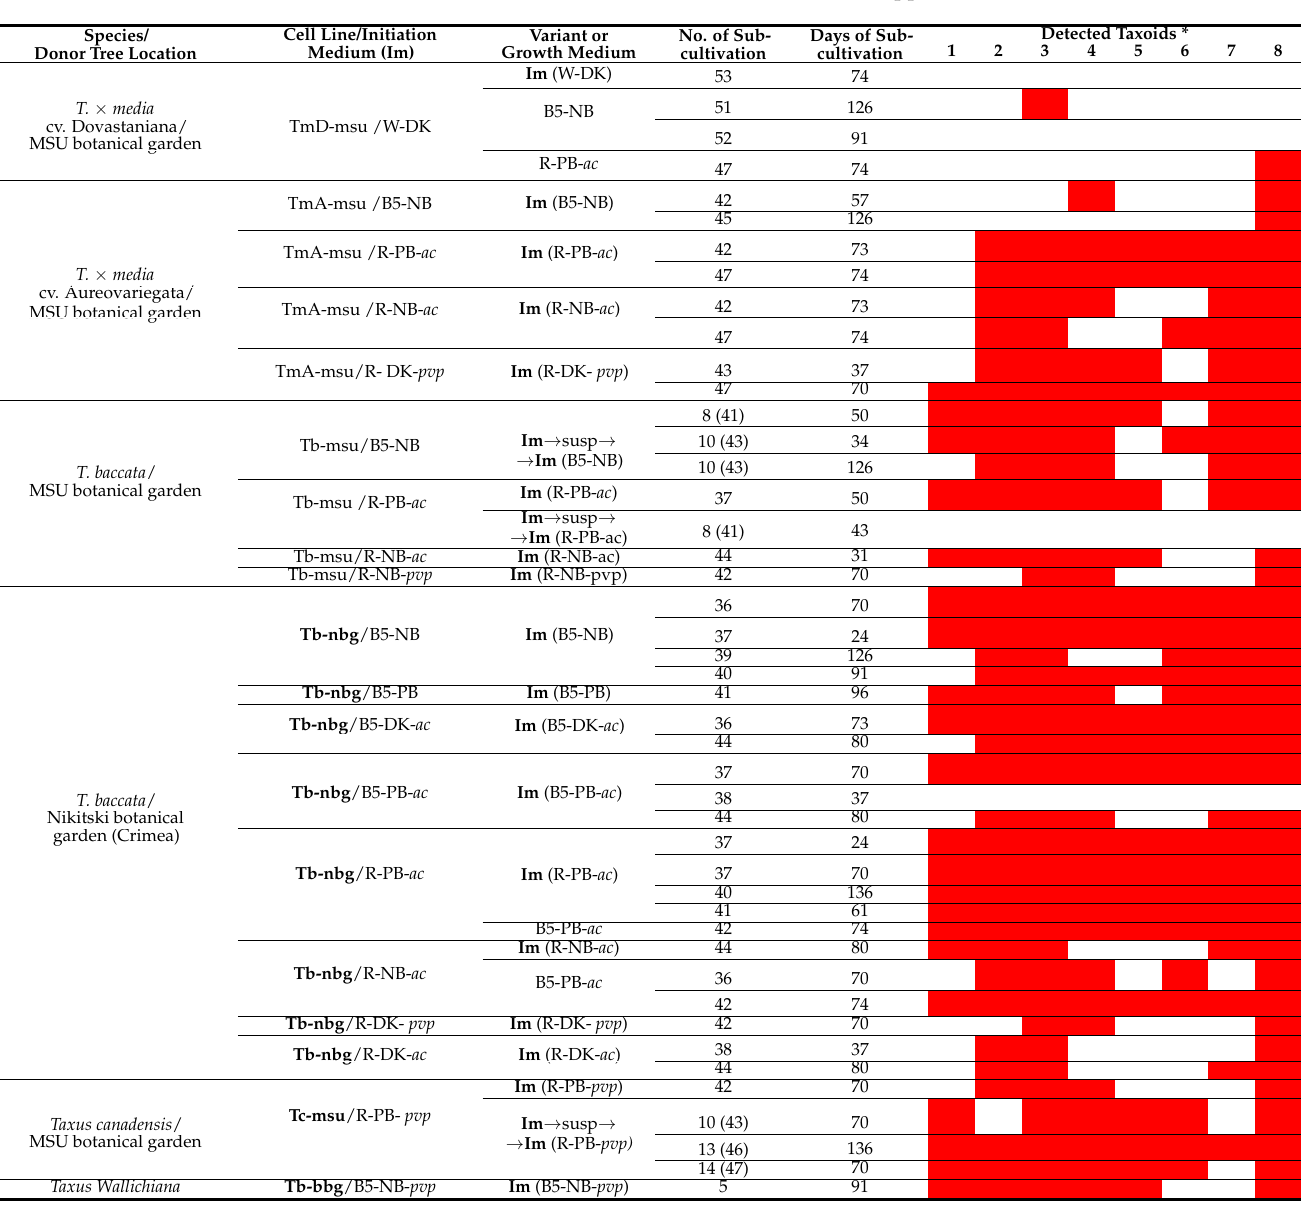
Table 5. Taxoids identified in callus cell cultures of Taxus